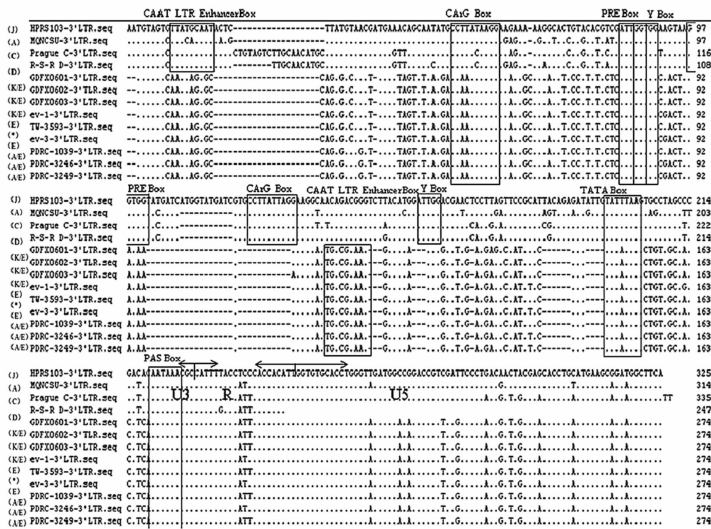
Figure 4. Nucleotide sequence alignments and motifs of the ALV LTR region. Dots ( · ) indicate identical residues, while letters indicate base substitutions. Dashes (–) indicate gaps in the alignment. Locations of putative transcriptional regulatory elements are indicated in boxes and are